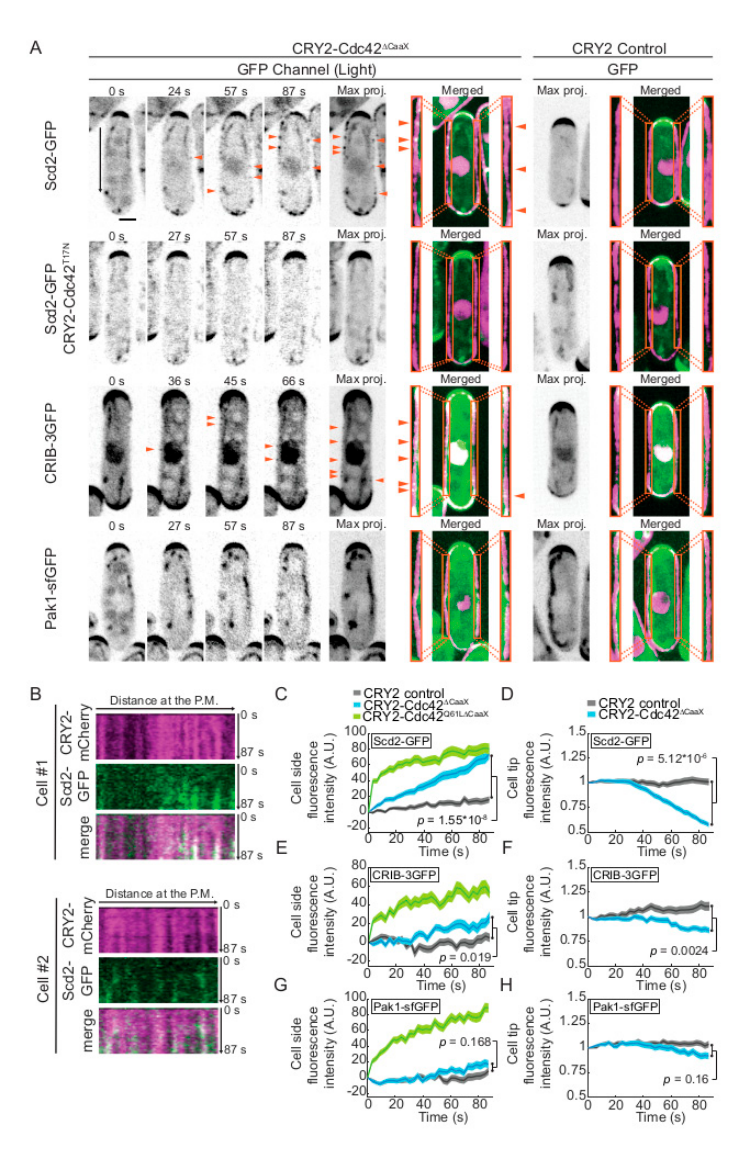
Figure 1. Ectopic sites of Cdc42 activation upon CRY2-Cdc42 ∆ CaaX cell-sides recruitment. ( A ) Localization of Scd2-GFP, CRIB-3GFP and Pak1-sfGFP in CRY2-Cdc42 ∆ CaaX -expressing cells (B / W inverted images and green channel in merge). The GFP max projection (“max proj.”) images show GFP maximum-intensity projections of 30 time points over 87 s. Merged images are composites of GFP and RFP max projections (t0 omitted from the RFP projection). Magnification of the lateral cortex is shown in the orange insets. Arrowheads point to lateral Scd2-GFP and CRIB-3GFP signal. The black arrow in Scd2-GFP panel indicates the cortical region in the kymograph shown in (B, cell #1). Note that autofluorescent organelles appear as linear and circular structures in some of the GFP channel images. ( B ) Kymograph at the lateral cell cortex for two cells over the 87 s (cell #1 corresponds to the cell shown in ( A )). ( C , D ) Quantification of Scd2-GFP signal intensity at cell sides ( C ) and cell poles ( D ). ( E , F ) Quantification of CRIB-3GFP signal intensity at cell sides ( E ) and cell poles ( F ). ( G , H ) Quantification of Pak1-sfGFP signal intensity at cell sides ( G ) and cell poles ( H ). In ( C – H ), n > 66 cells. Exact numbers are listed in the methods. In ( C , E , G ), the CRY2-Cdc42 Q61L, ∆ CaaX average trace is shown for cell-side recruitment comparison (data from (Lamas et al., 2020)). In all graphs, thick line = average; shaded area = standard error of the mean (SEM); WT, wild type; A.U., arbitrary units. Bars = 2 µ m. Associated trace analysis is shown in Figure S2A for cell-side and Figure S2B for cell pole